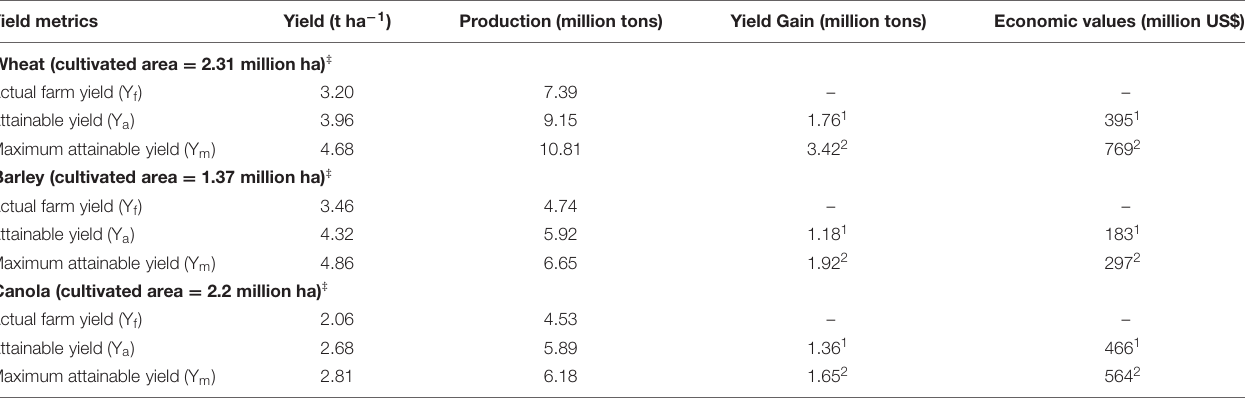
TABLE 7 | Estimated yield gain in wheat, barley, and canola due to improved crop management and genetic selection under rainfed condition in Alberta. Yield metrics Yield (t ha − 1 ) Production (million tons) Yield Gain (million